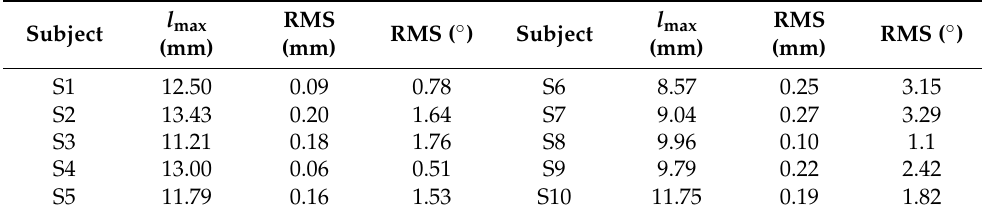
Table 4. Results of fast calibration.